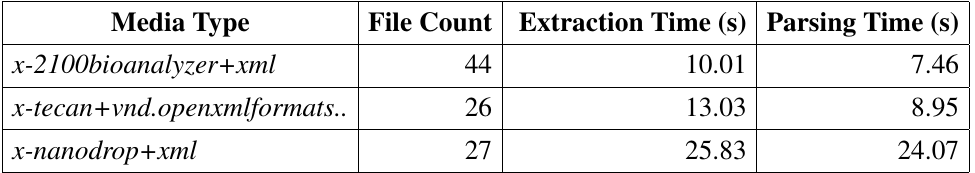
Table 2. Performance of Parsers and